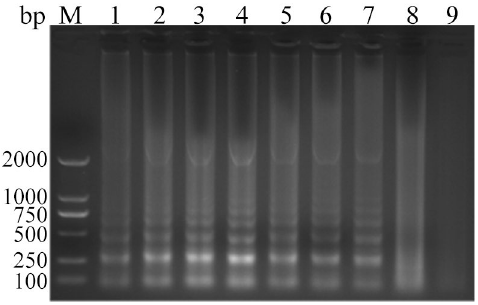
Figure 8. Analysis of ALV-J CPA with different reaction times by agarose gel electrophoresis. Lane M, DNA marker; 1, 15 min; 2, 30 min; 3, 45 min; 4, 60 min; 5, 75 min; 6, 90 min; 7, 105 min; 8, 120 min; 9, Negative control amplification for 120 min. The full-length gel is presented in Supplementary Figure S24.